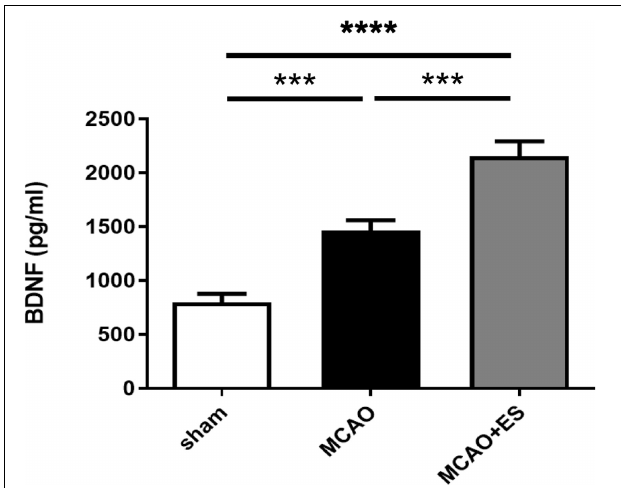
FIGURE 6 | Electrical stimulation treatment enhances the expression of brain-derived neurotrophic factor (BDNF) after tMCAO. Expression of BDNF in penumbra was evaluated by ELISA (Sham n = 8; MCAO n = 8; and MCAO + ES n = 8). *** p ≤ 0.001; **** p ≤